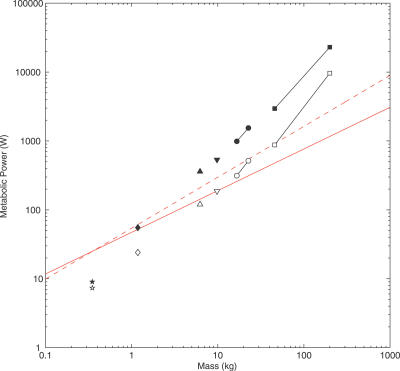
Estimated Metabolic CostsEstimated metabolic costs of steady flapping flight in ground effect (V
mp) with (filled symbols) and without (open symbols) the tip of the mandible immersed in water. Stars, R. n. cinerascens; diamonds, Tupuxuara sp.; up-triangles, Thalassodromeus fragment; down-triangles, Thalassodromeus holotype; circles, Pteranodon; squares, Quetzalcoatlus. Solid red line indicates estimated maximum available metabolic power (47.126M
0.605) [29], broken red line the theoretically maximum available metabolic power (54.144M
0.739) [29].